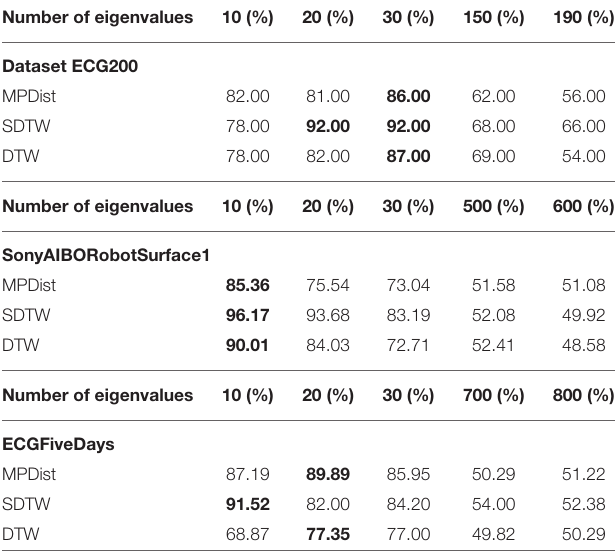
TABLE 4 | Varying the number of eigenpairs for the reduced Allen–Cahn equation. Number of